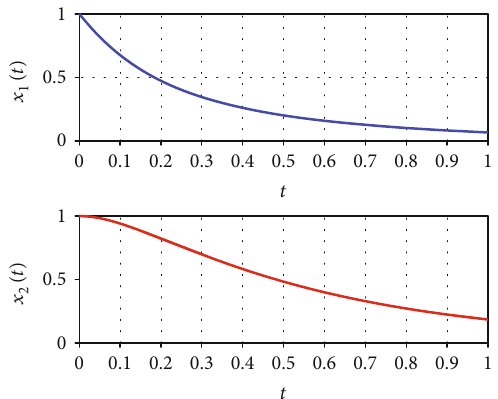
Figure 1: The numerical results for system (60) at c ð μ Þ = − δ ð μ − 2 /3 Þ for Example 19.